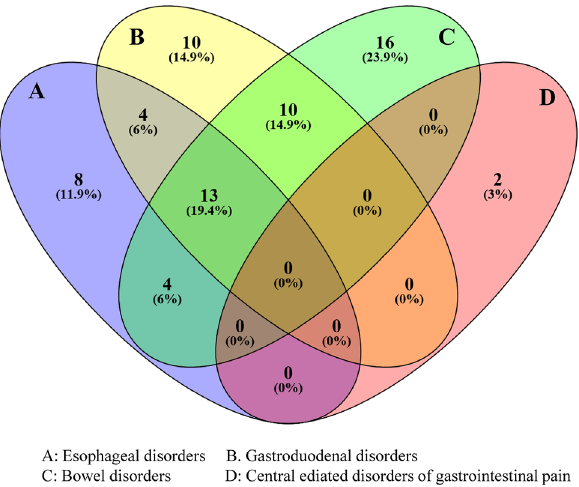
Figure 1. Venn diagram of the combined FGIDs between esophageal, gastroduodenal, bowel and anorectal disorders in the respondents based on Rome IV criteria.